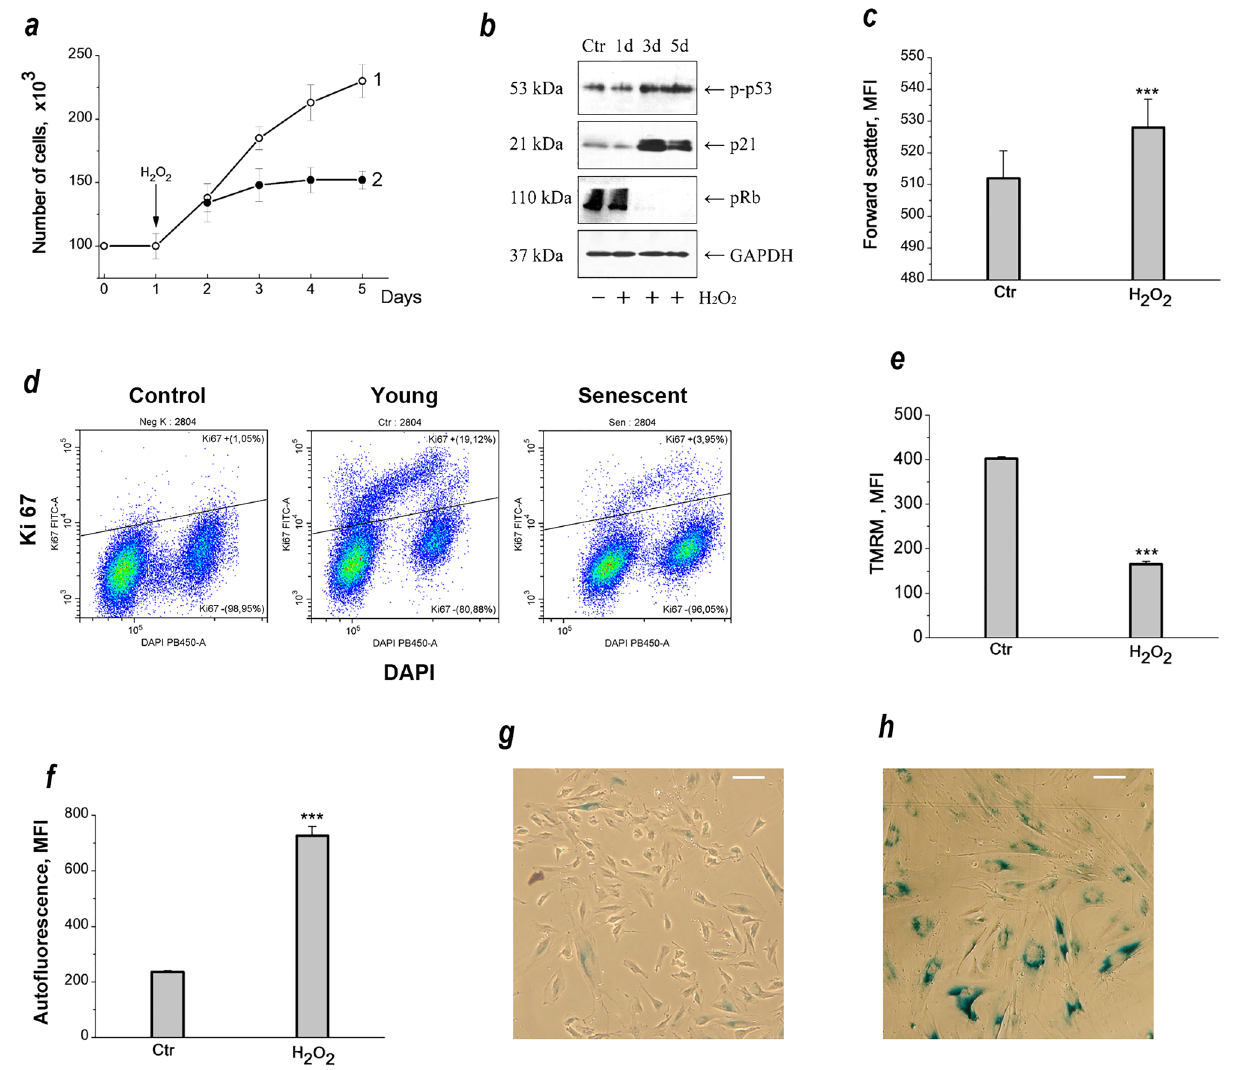
Figure 1. Oxidative stress induces premature senescence in hMESCs. ( a ) Growth curves of control (1) and H 2 O 2 -treated (2) hMESCs. ( b ) H 2 O 2 -induced activation of p53/p21/Rb pathway in hMESCs. Western blot analysis of p53 and Rb phosphorylation levels as well as p21 protein expression performed at indicated time points after H 2 O 2 treatment. Representative results of the three experiments are shown. Ctr—control (untreated) hMESCs cultured in standard conditions; GAPDH was used as loading control. The original blots were cut prior to antibody treatment during blotting. The original blots are provided in Supplementary Fig. 1b. ( c ) Forward scatter reflecting cell size change on the 5th day after the oxidative stress. ( d ) Cell cycle phase distribution of the proliferation marker Ki-67 in proliferating young and senescent hMSCs. FITC mouse IgG1 is presented as a negative control. Representative Pseudo Color Plots are shown. ( e ) Mitochondrial membrane potential is decreased on the 5th day after oxidative stress as revealed by TMRM (tetramethylrhodamine, methyl ester) fluorescence. ( f ) Lipofuscin accumulation estimated by autofluorescence measurement on the 5th days after the stress. ( g, h ) Representative microphotographs of SA-β-Gal staining in control ( g ) and stressed hMESCs ( h ). Scale bar is 50 µm. In ( a ), ( c ), ( e ) and ( f ) data are presented as mean ± SD (n = 3), *** p < 0.005 versus the control cells (Ctr). MFI, mean fluorescence intensity; SA-β-Gal, senescence associated